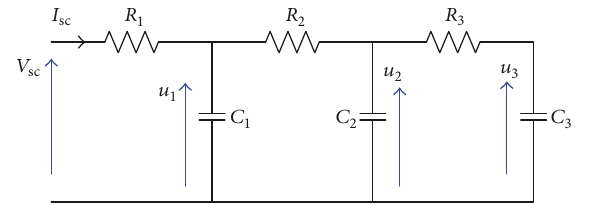
Figure 5: Three-stage ladder model.